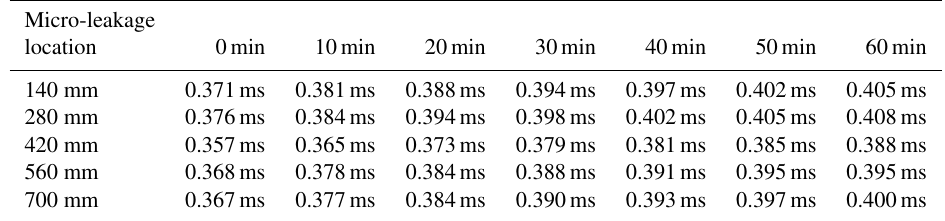
Figure 9. Phase shift of ultrasonic sensor envelope signal filtered through a Gaussian distribution for micro-leakage location of 700mm. Table 4. Phase shift according to the pressure shift inside the